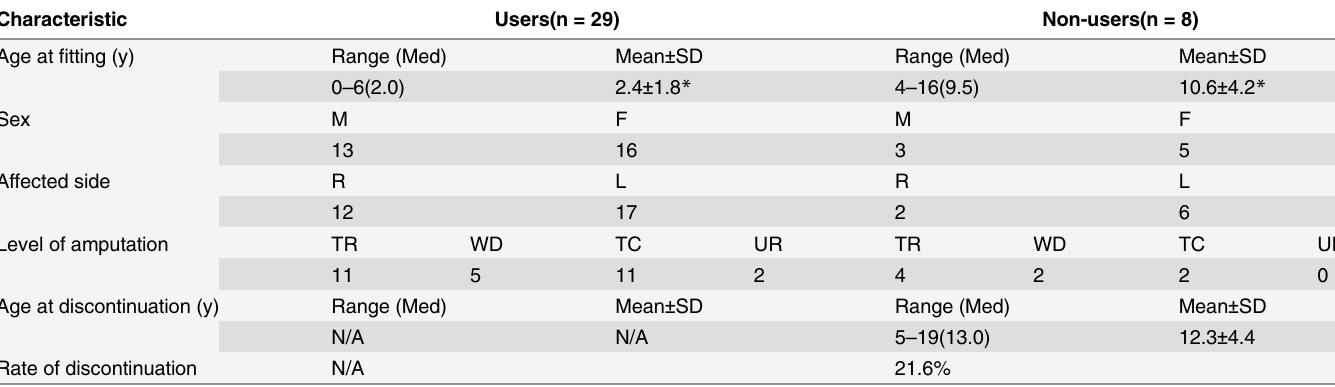
Table 2. Charactristics of users and non-users and age when discontinuing the prosthesis.